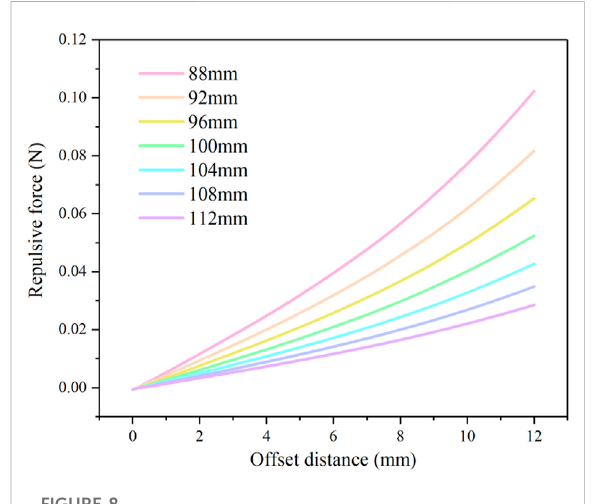
FIGURE 10 Compared simulation and experiment results of